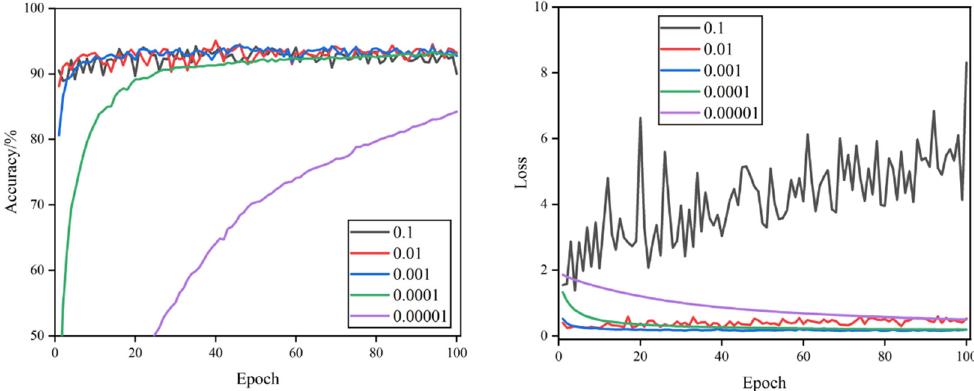
Figure 8. Validation accuracy and loss curves of different learning rates when dropout = 0.75.